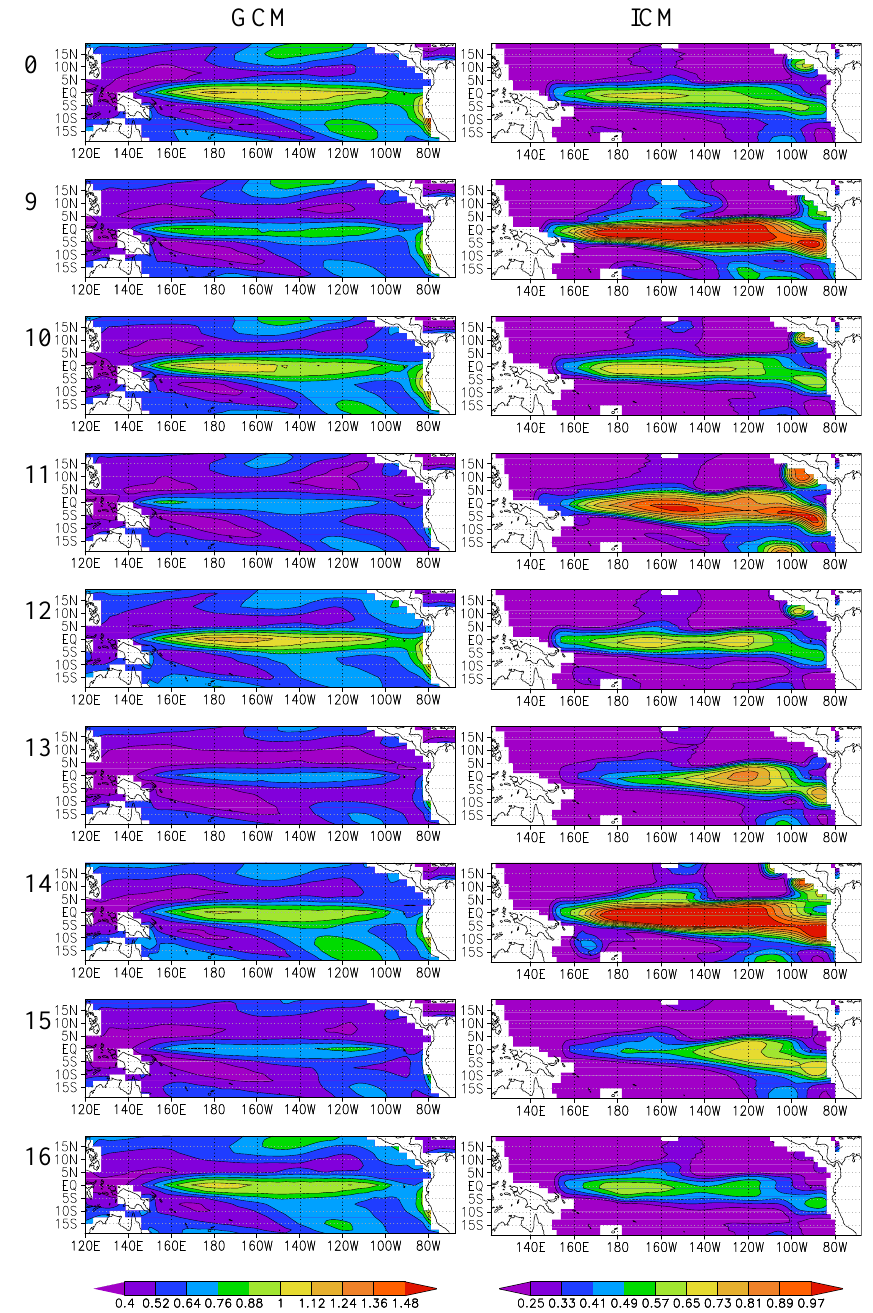
Fig. 8b. STAM-member and ATM-members 9–16.